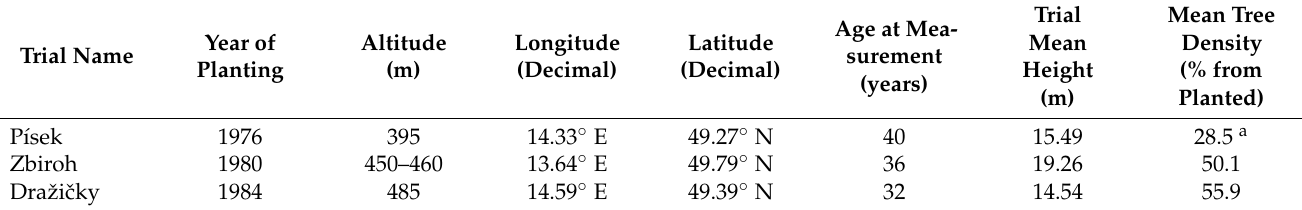
Table 1. Basic data of the three trials and their mean height and tree density in 2015. Adapted from [20].